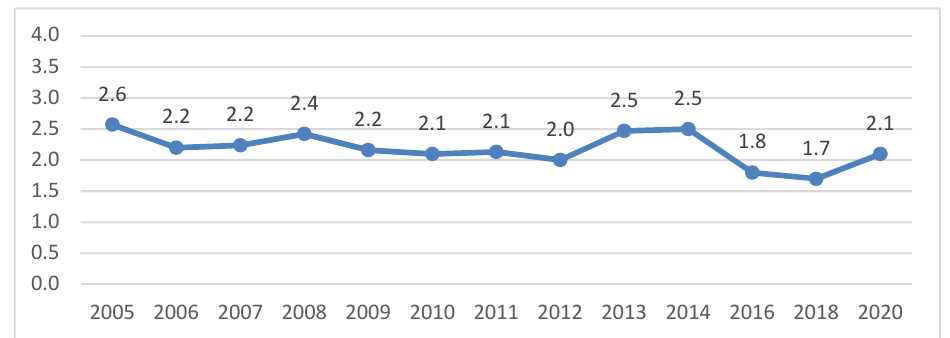
Figure 14. The General Diversity Index based on three weighted positive and three weighted negative statements about diversity.